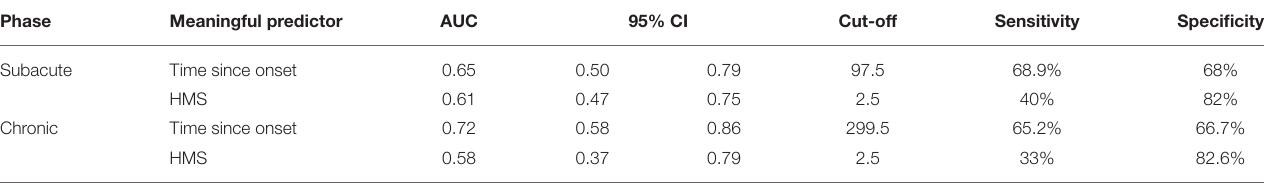
TABLE 3 | The sensitivity and specificity for the cut-off score of the meaningful predictors according to stroke phase.